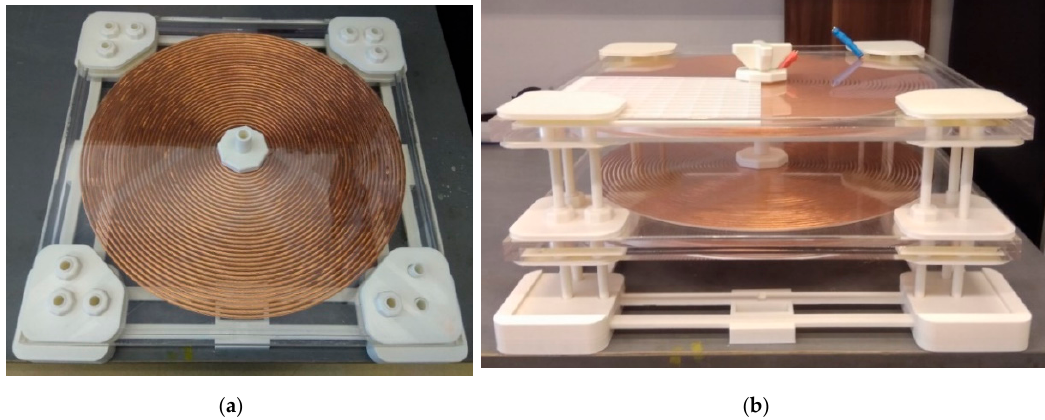
Figure 3. Coil´s winding located within plexiglass matrices ( a ) and system of coupling coils of proposed wireless charging system with adjustable transfer distance ( b ).